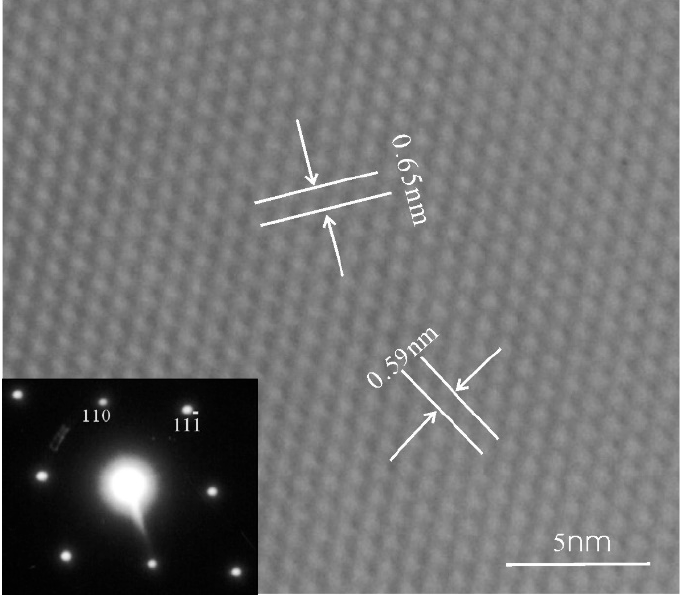
Figure 1. TEM image and electron diffraction pattern of colorless orthoclase.